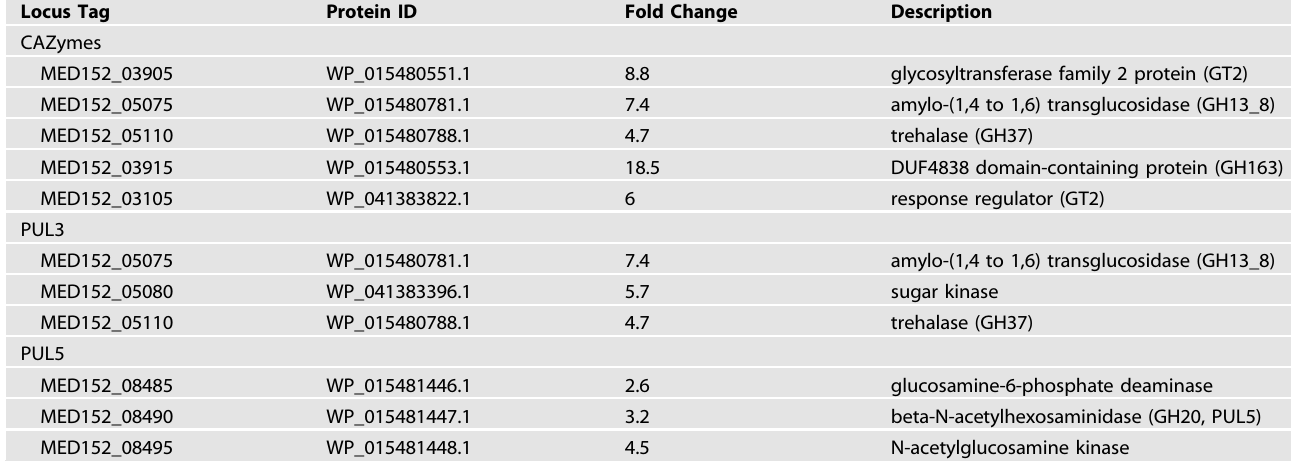
Table 3. Signi fi cantly enriched transporter system genes and carbohydrate-active enzymes in the transcriptome of Polaribacter dokdonensis MED152 in co-culture with M. commoda